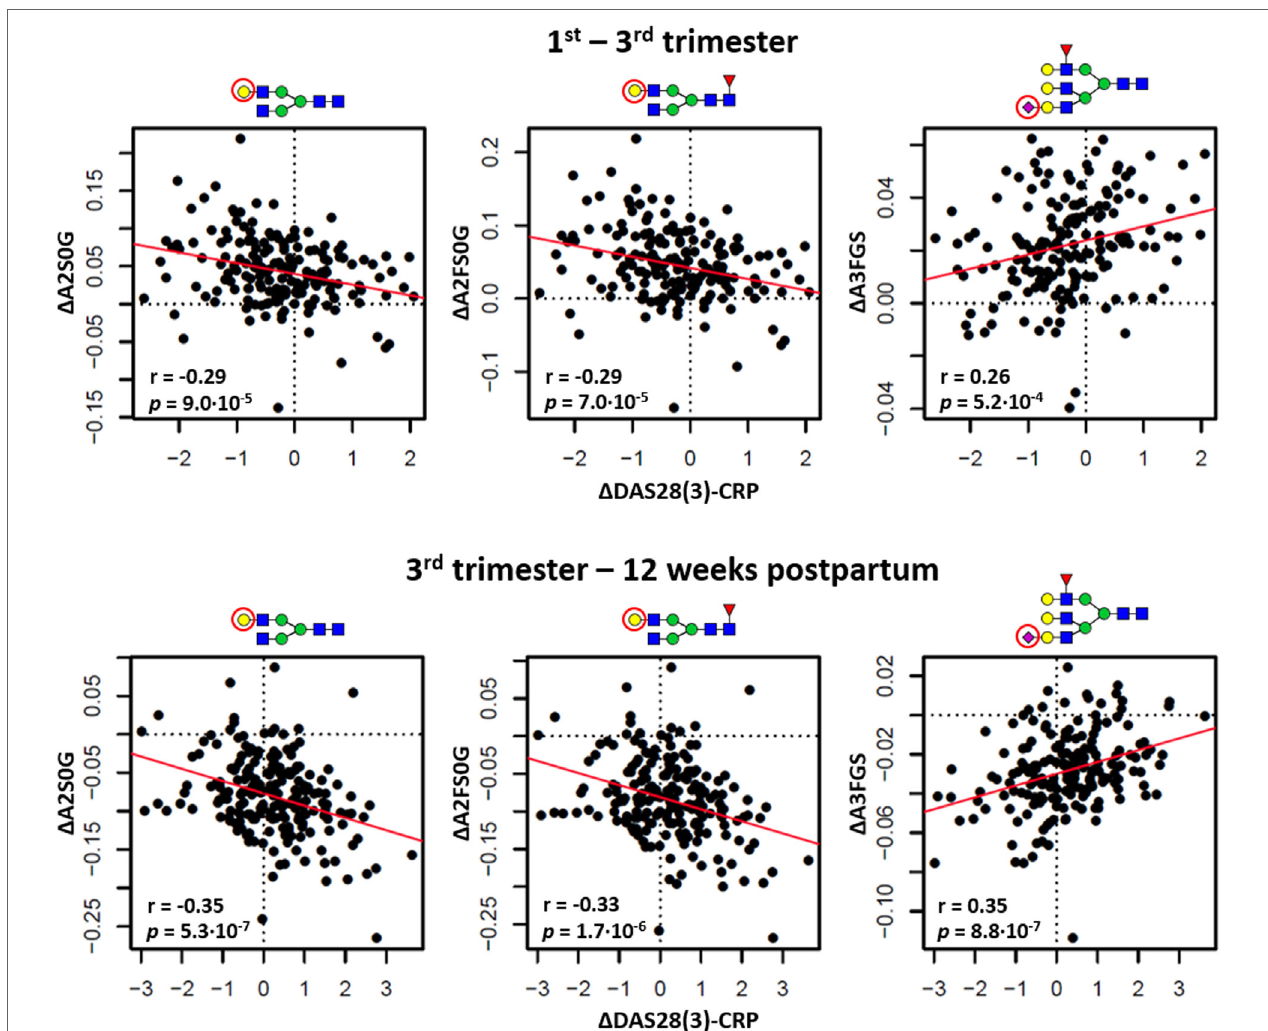
FigUre 5 | The relation between changing rheumatoid arthritis disease activity [ Δ DAS28(3)-CRP] and changing glycosylation. Distinction is made between the timeframes to assess responder status (the change between first and third trimester; top row ) and flare status (the change between third trimester and 12 weeks postpartum; bottom row ). Δ A2S0G, the change in galactosylation per antenna of diantennary non-sialylated species; Δ A2FS0G, the change in galactosylation of diantennary fucosylated non-sialylated species; Δ A3FGS, the change in sialylation per galactose of triantennary fucosylated species. The significance of the models ( p ) arrives from linear regression, the correlation coefficients ( r ) from Pearson